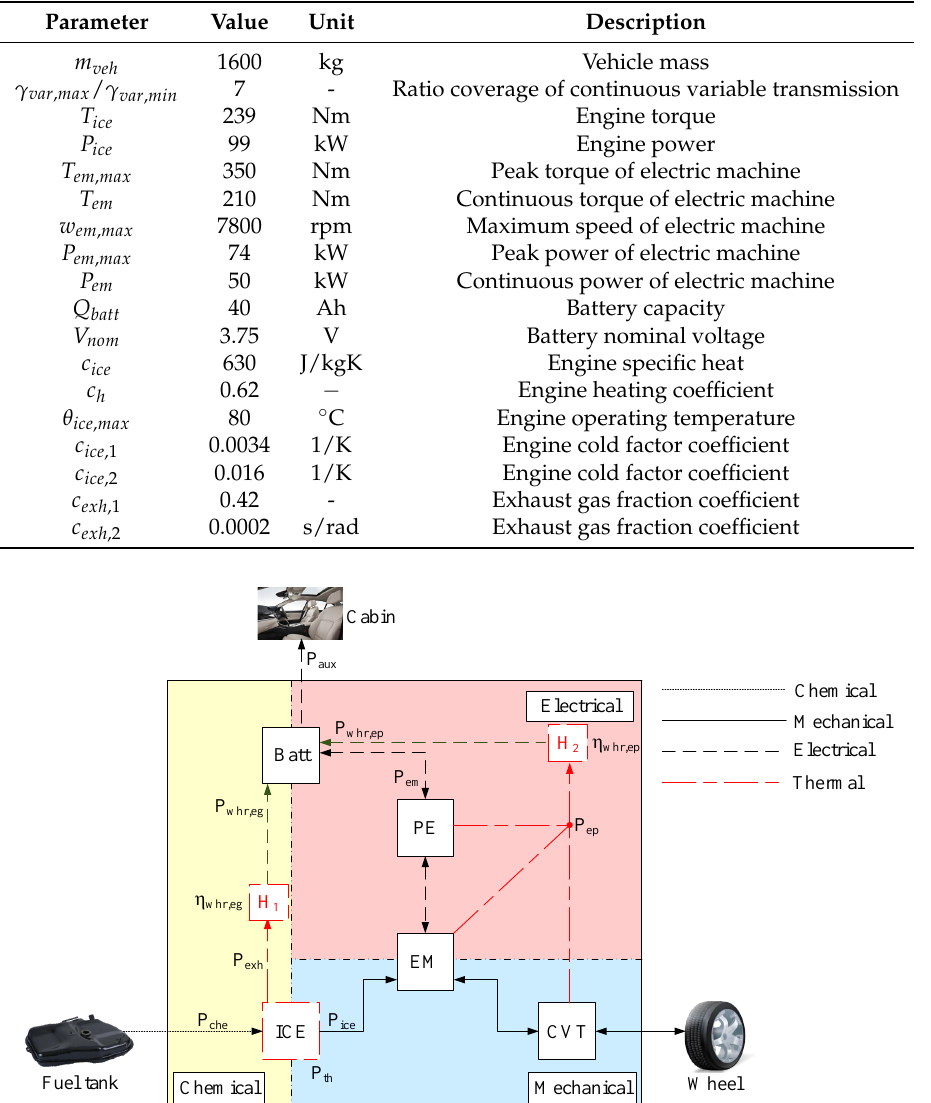
Table 1. Main model parameters.